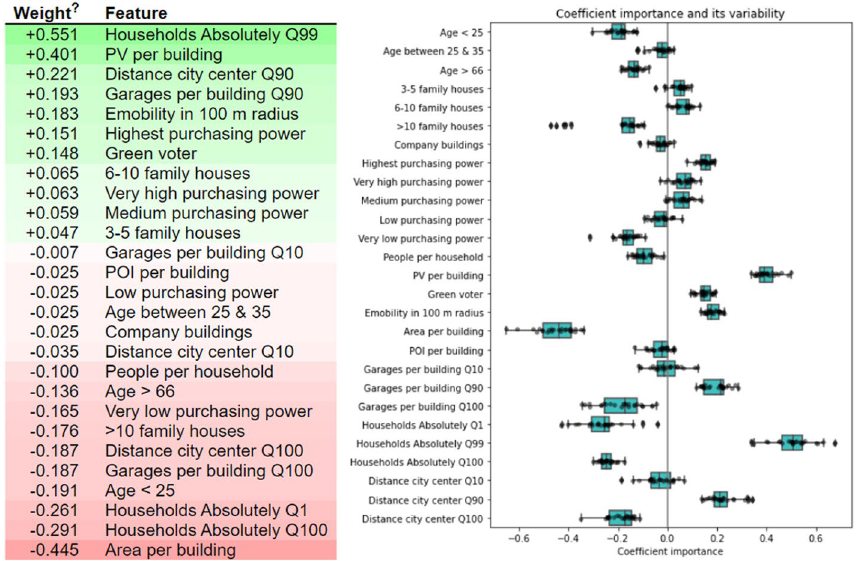
Fig. 3 Coefficient analysis of the logistic regression